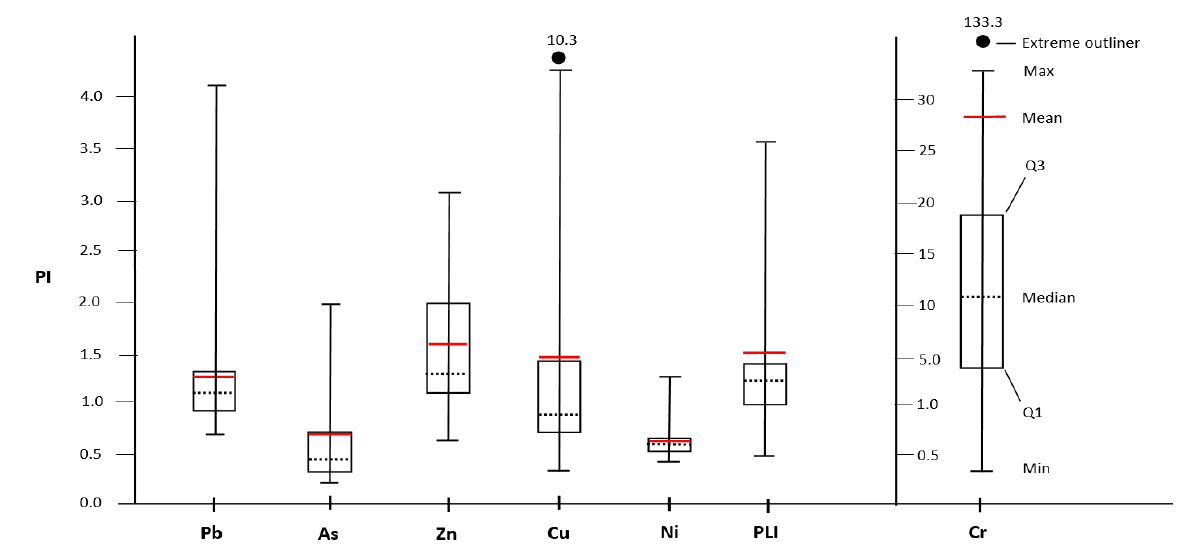
Figure 2 . Box-plots of pollution index (PI) and pollution load index (PLI) for heavy